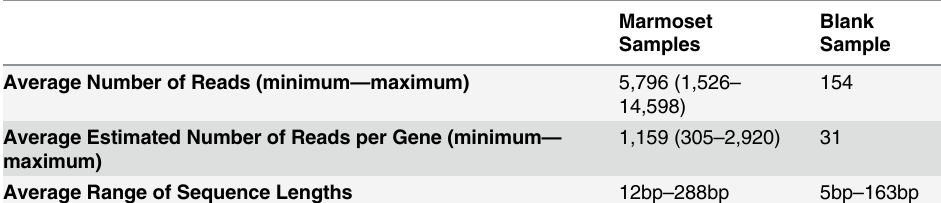
Table 2. Summary of sequencing